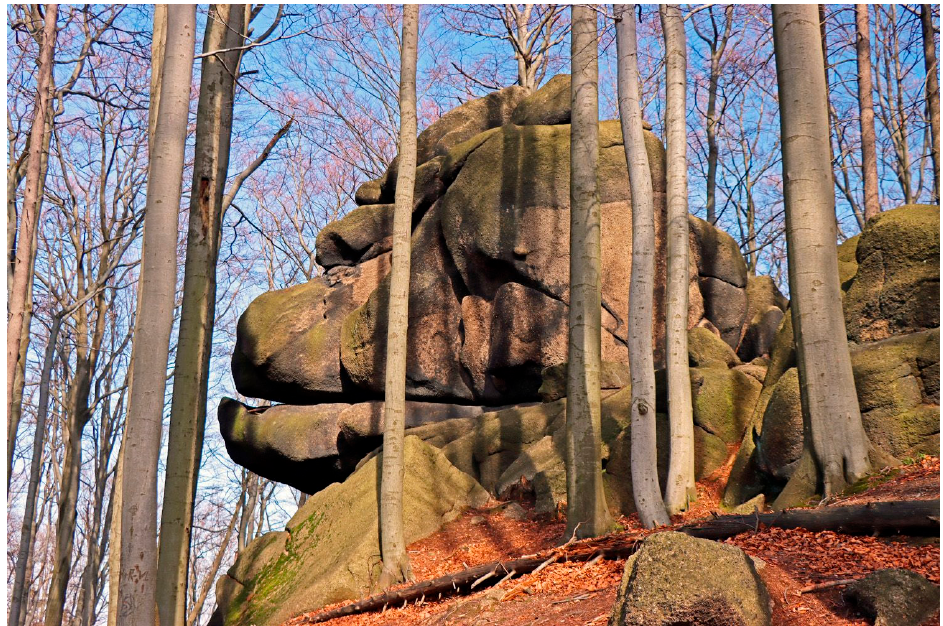
Figure 3. Gorilla Rock made of Liberec granite. Photo by author.